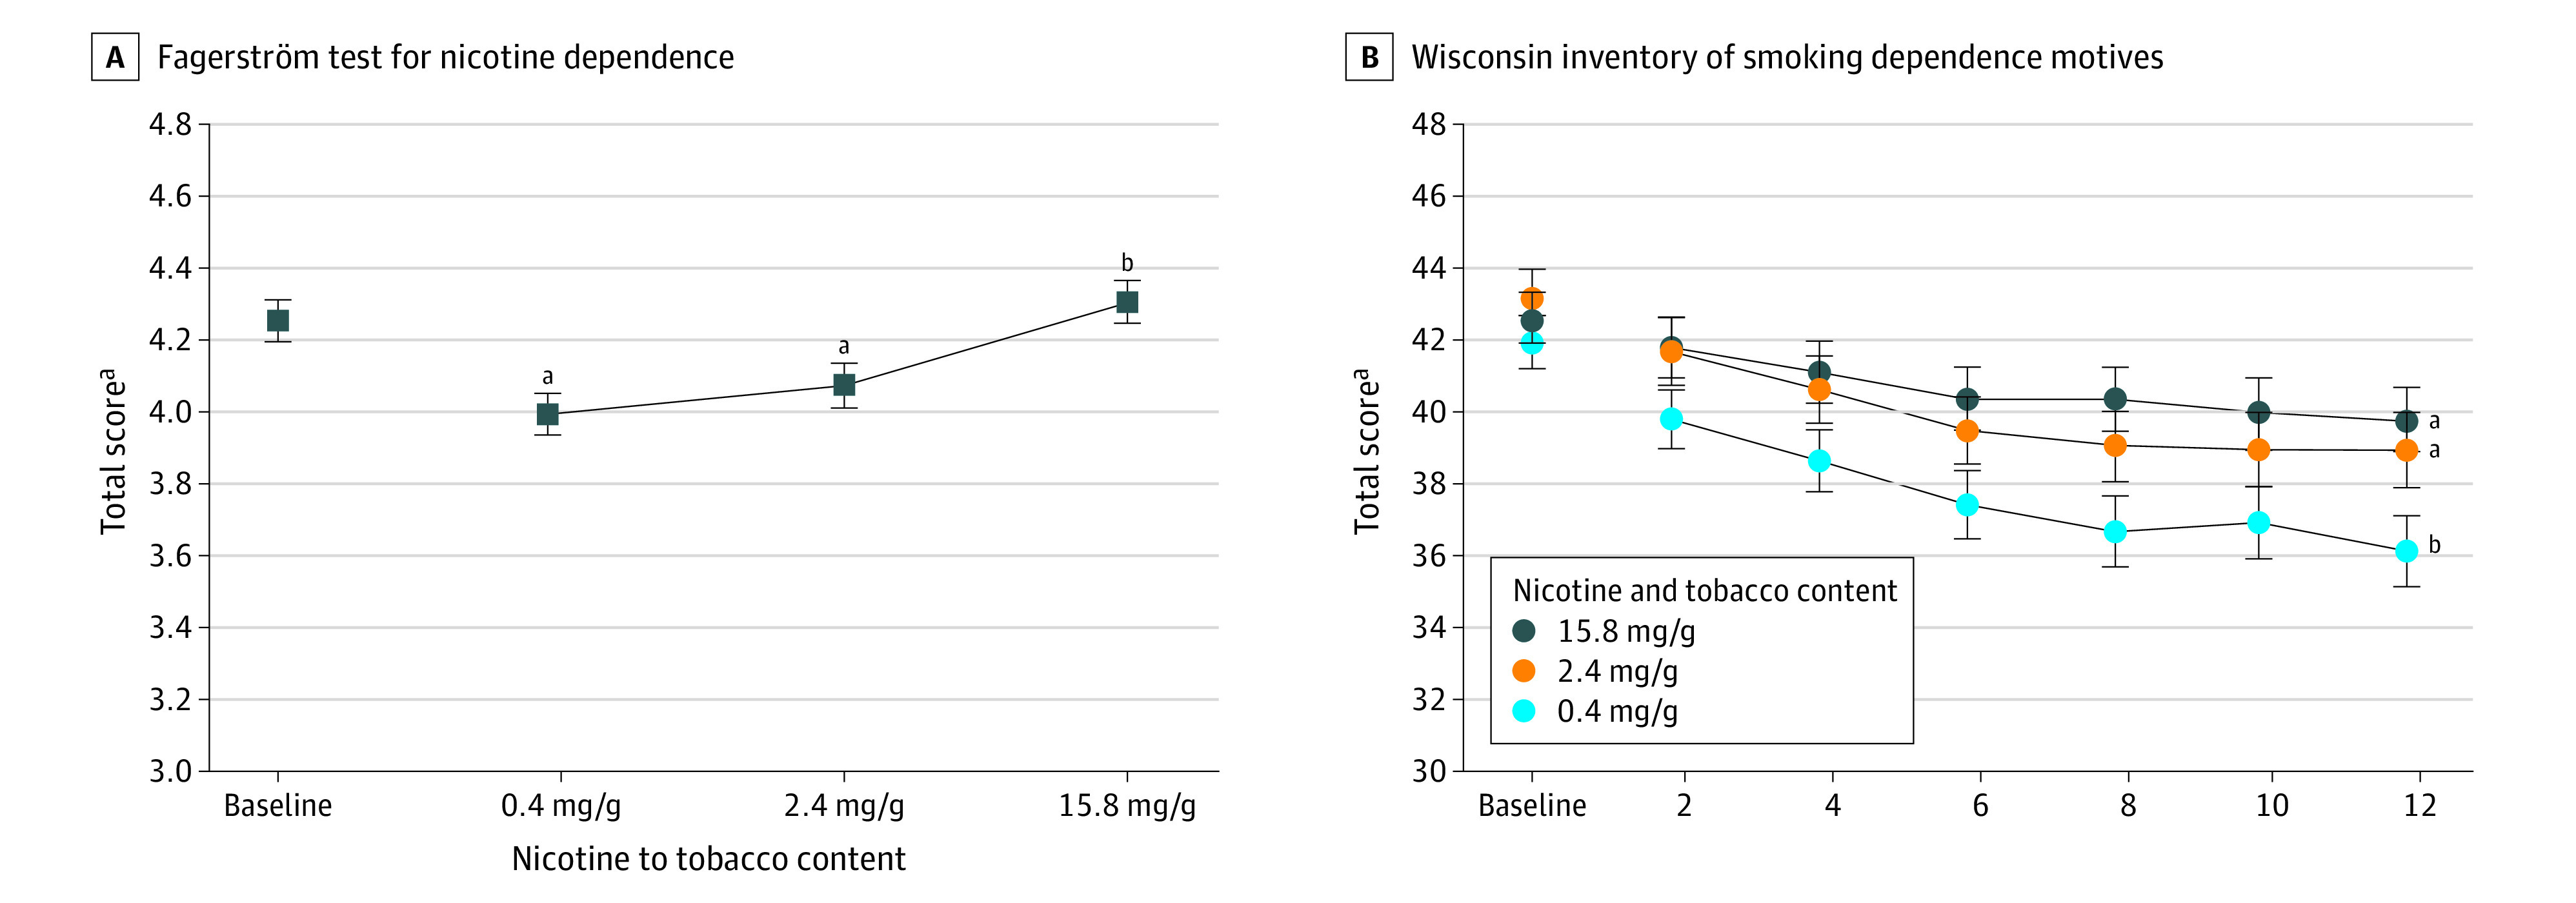
Changes in Nicotine Dependence SeverityA, Data points are arithmetic means collapsed across participants, time, and populations; error bars indicate SEM. Data points not sharing a superscript letter differed significantly by dose in post hoc testing. B, Data points are arithmetic means collapsed across participants and populations at each assessment; error bars indicate SEM. Doses not sharing a superscript letter differed in slope of linear trends.